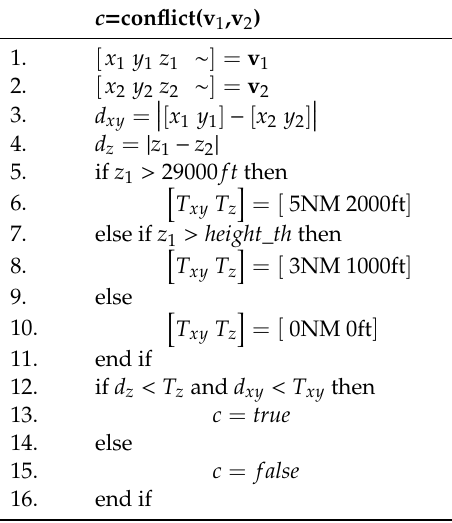
Table 2. Conflict detection algorithm.